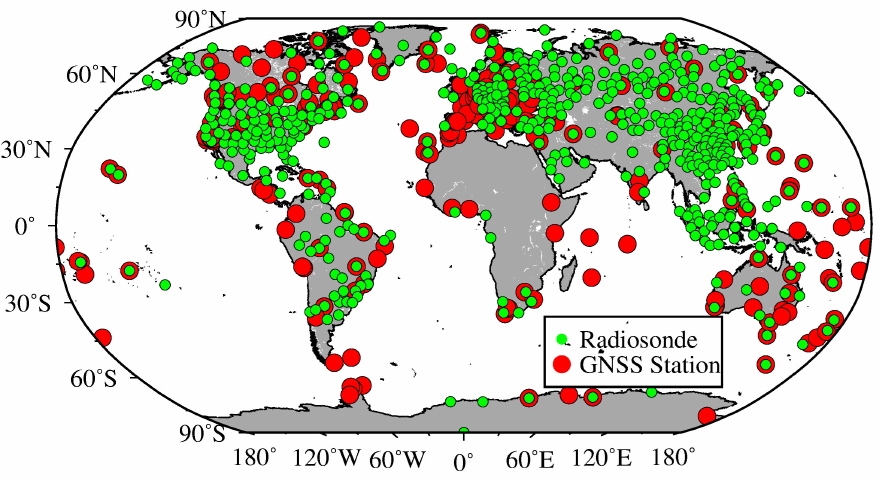
Figure 1. Distribution of global radiosonde and GNSS